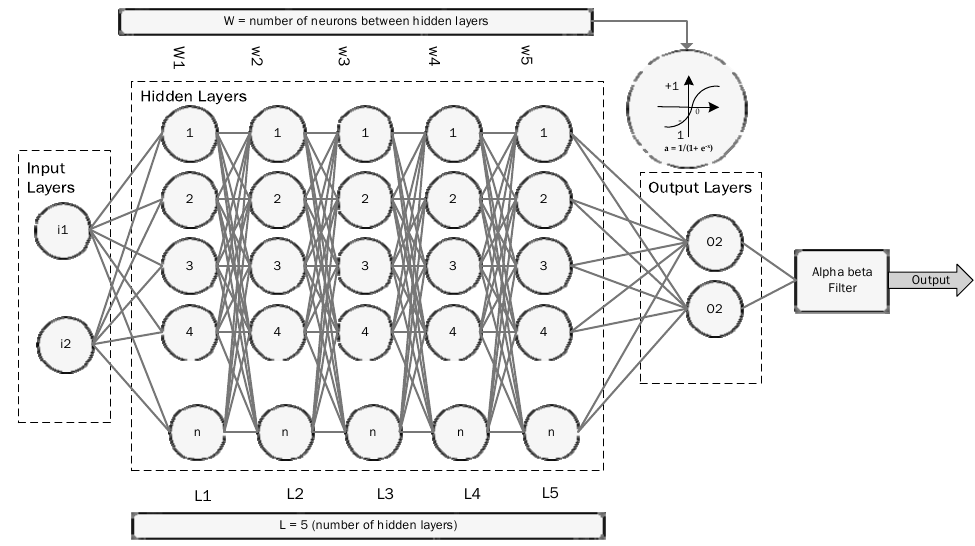
Figure 4. Structure of DELM with alpha-beta filter .